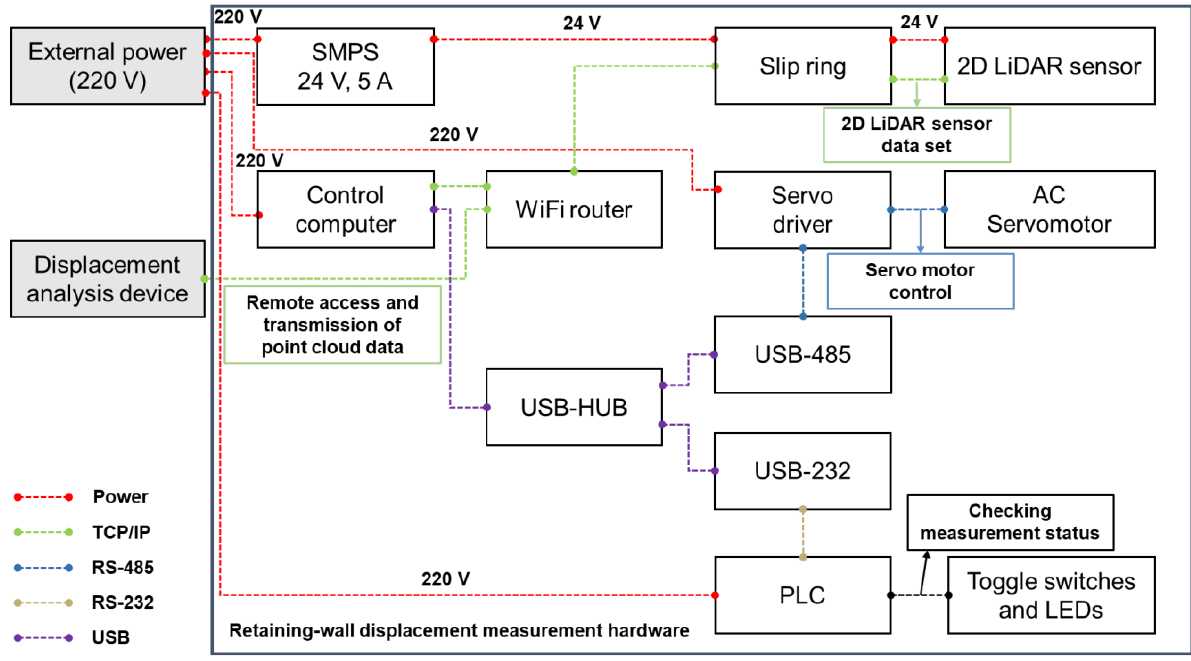
Figure 4. Configuration of 2D LiDAR sensor-based retaining wall displacement measurement sys- tem.